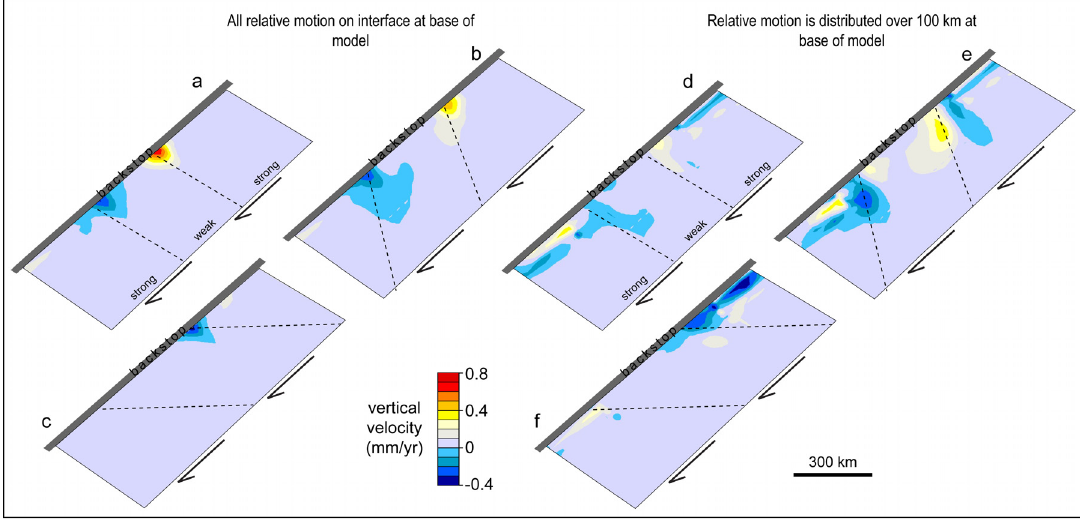
Figure 8. Map view of vertical displacement for models with an asymmetric strike slip boundary condition against a backstop. Models ( a ) to ( c ) have a basal boundary condition which focuses all the relative motion on the interface between the backstop and the model domain. Models ( d ) to ( f ) have a basal boundary condition which distributes the relative motion over 100 km; ( a ) The rheological boundaries between the strong and weak regions are perpendicular to the boundary conditions. A region of subsidence, overlying the weak to strong transition, occurs just north of the transition; ( b ) The rheological boundaries are at 45° to the strike-slip boundary condition. A region of subsidence, similar to ( a ) develops; ( c ) The rheological boundaries are at 135° to the boundary condition. A small region of subsidence develops to the north; ( d – f ) Results are similar to the model counterparts in ( a – c ) but locus of subsidence has moved away from the backstop. Uplift and subsidence also occur above the boundary condition, adjacent to the backstop.